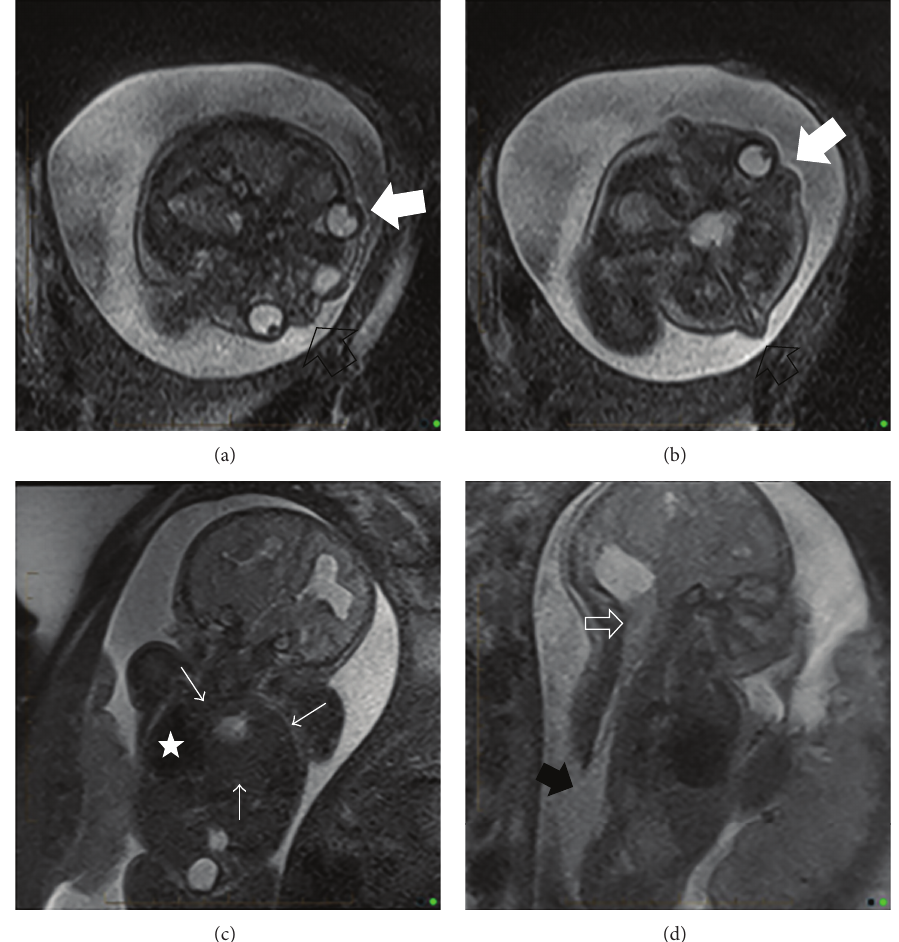
Figure 1: Axial images from fetal MRI (a and b) showing the left-sided (open black arrows) and right-sided (solid white arrows) fetal faces. Coronal image from fetal MRI (c) reveals a left-sided diaphragmatic hernia (thin white arrows) containing liver and bowel with displacement of the fetal heart (white star) to the right. Chiari II malformation with tonsillar herniation through the posterior foramen magnum (open white arrow) and associated lumbosacral spinal dysraphism (solid black arrow) is noted on a sagittal image (d).